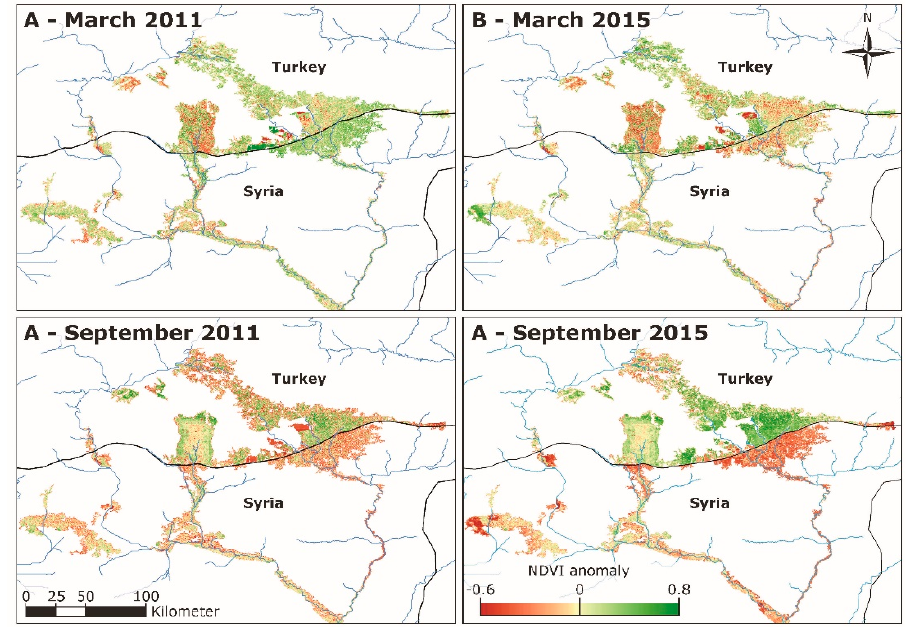
Figure 6. The MODIS-derived NDVI anomaly (departure from the normal) for key months in Turkey and Syria. March 2011 ( A ); March 2015 ( B ); September 2011 ( C ); and September 2015 ( D ). The March images, which represent rainfed crops, do not show a significant NDVI.